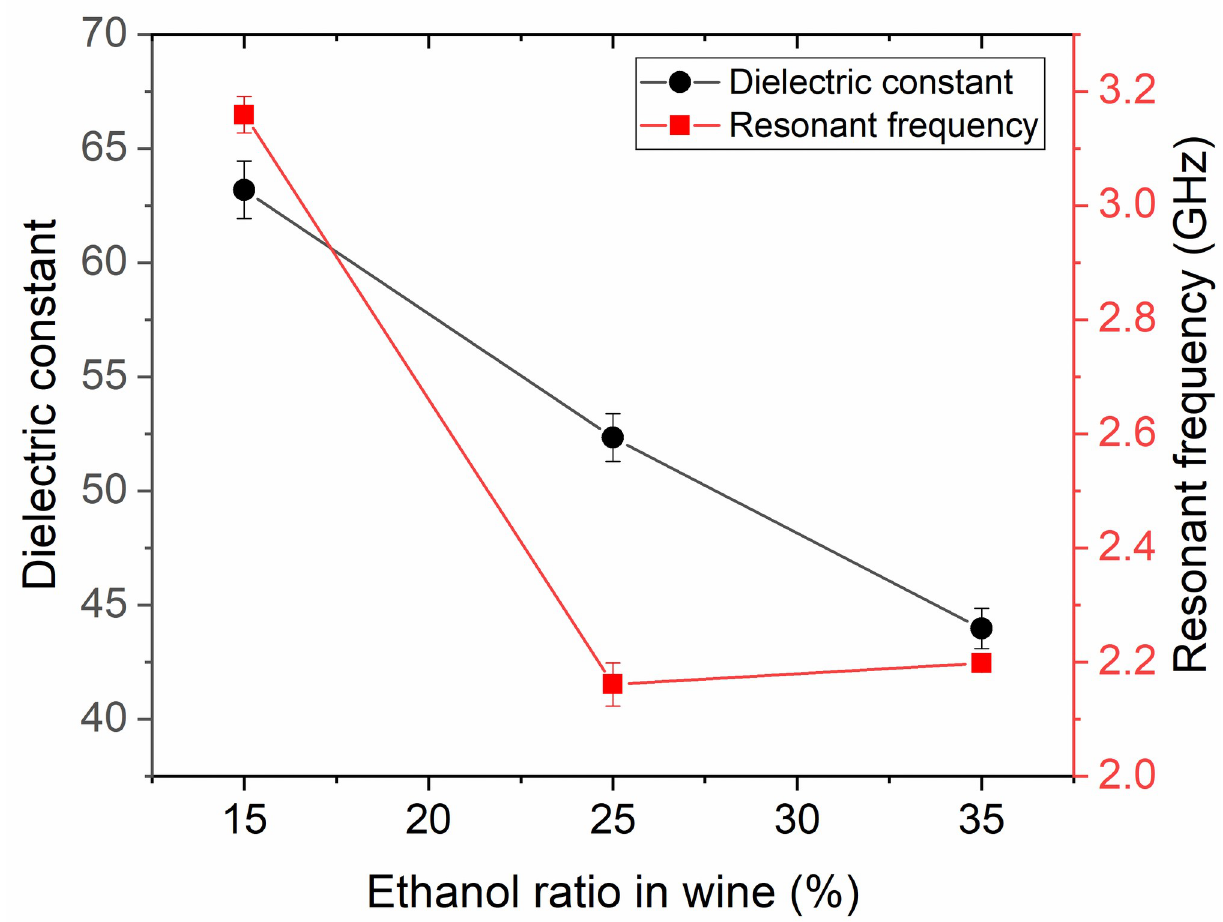
Fig 8. Variation of the resonant frequency with ethanol ratio in wine for the PCB rectangular antenna sensor.